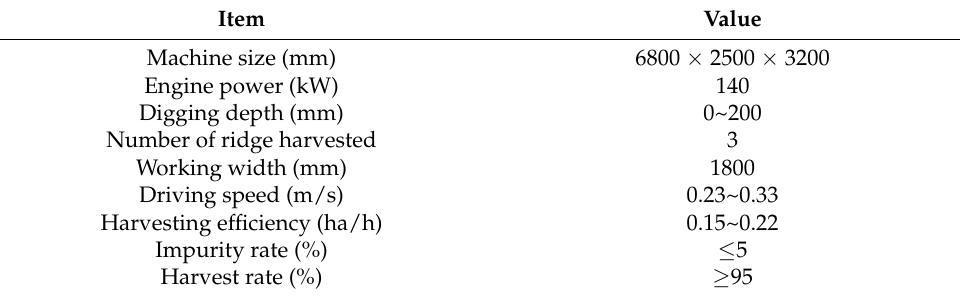
Table 2. Parameters table of the tiger-nut combine